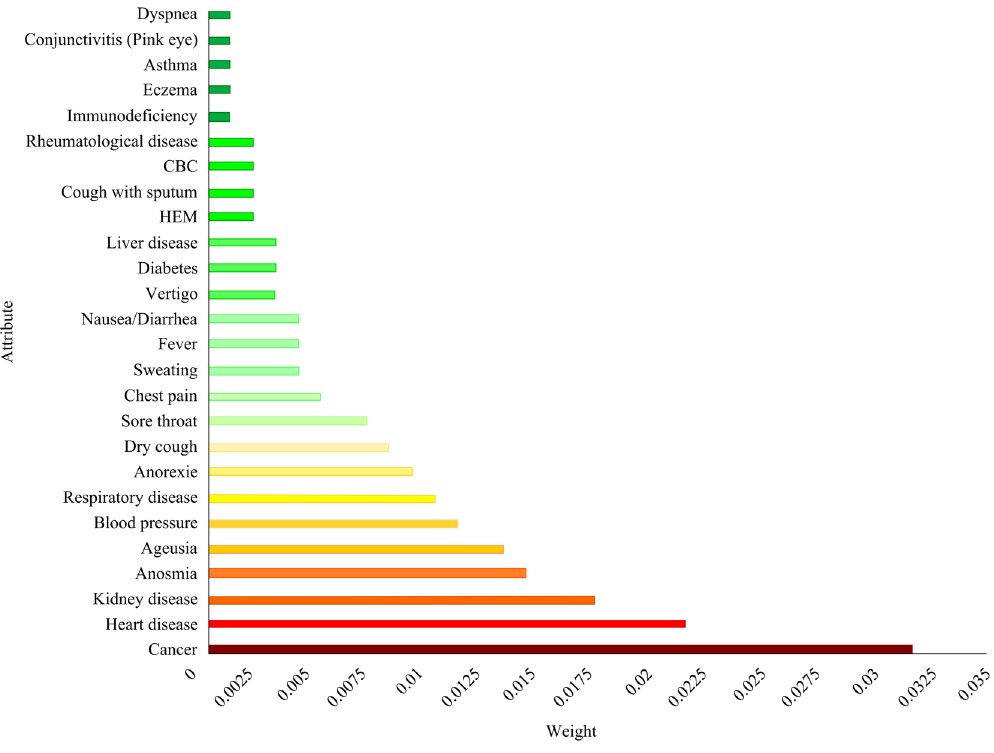
Figure 3. Feature effects on mortality rate based on